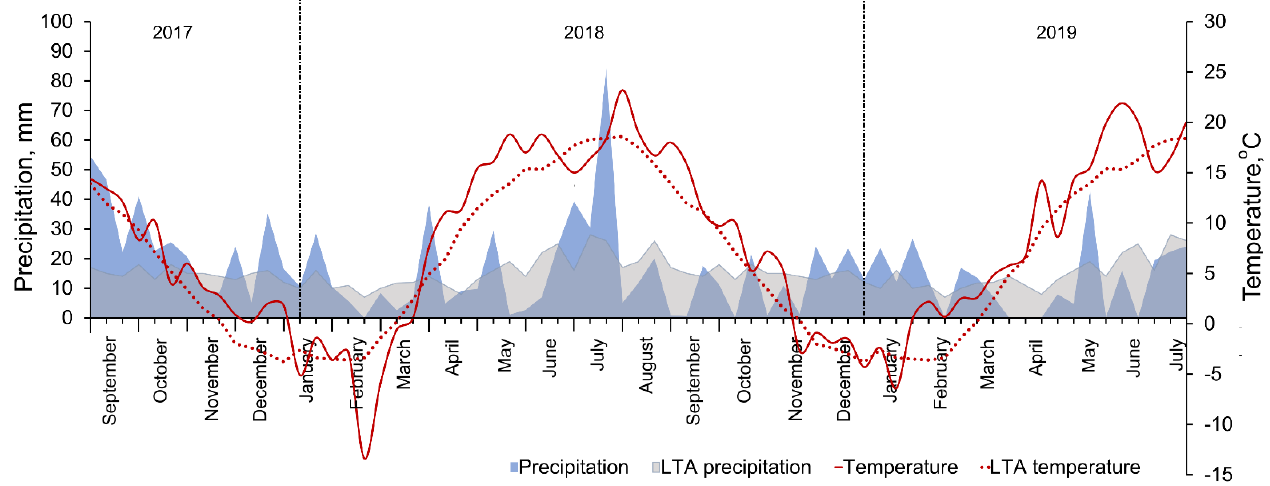
Figure 1. Meteorological conditions—precipitation and air temperature—during winter wheat growing seasons of 2017–2019 and long-term average (LTA, 1924–2019). (Dotnuva Meteorological Station data).